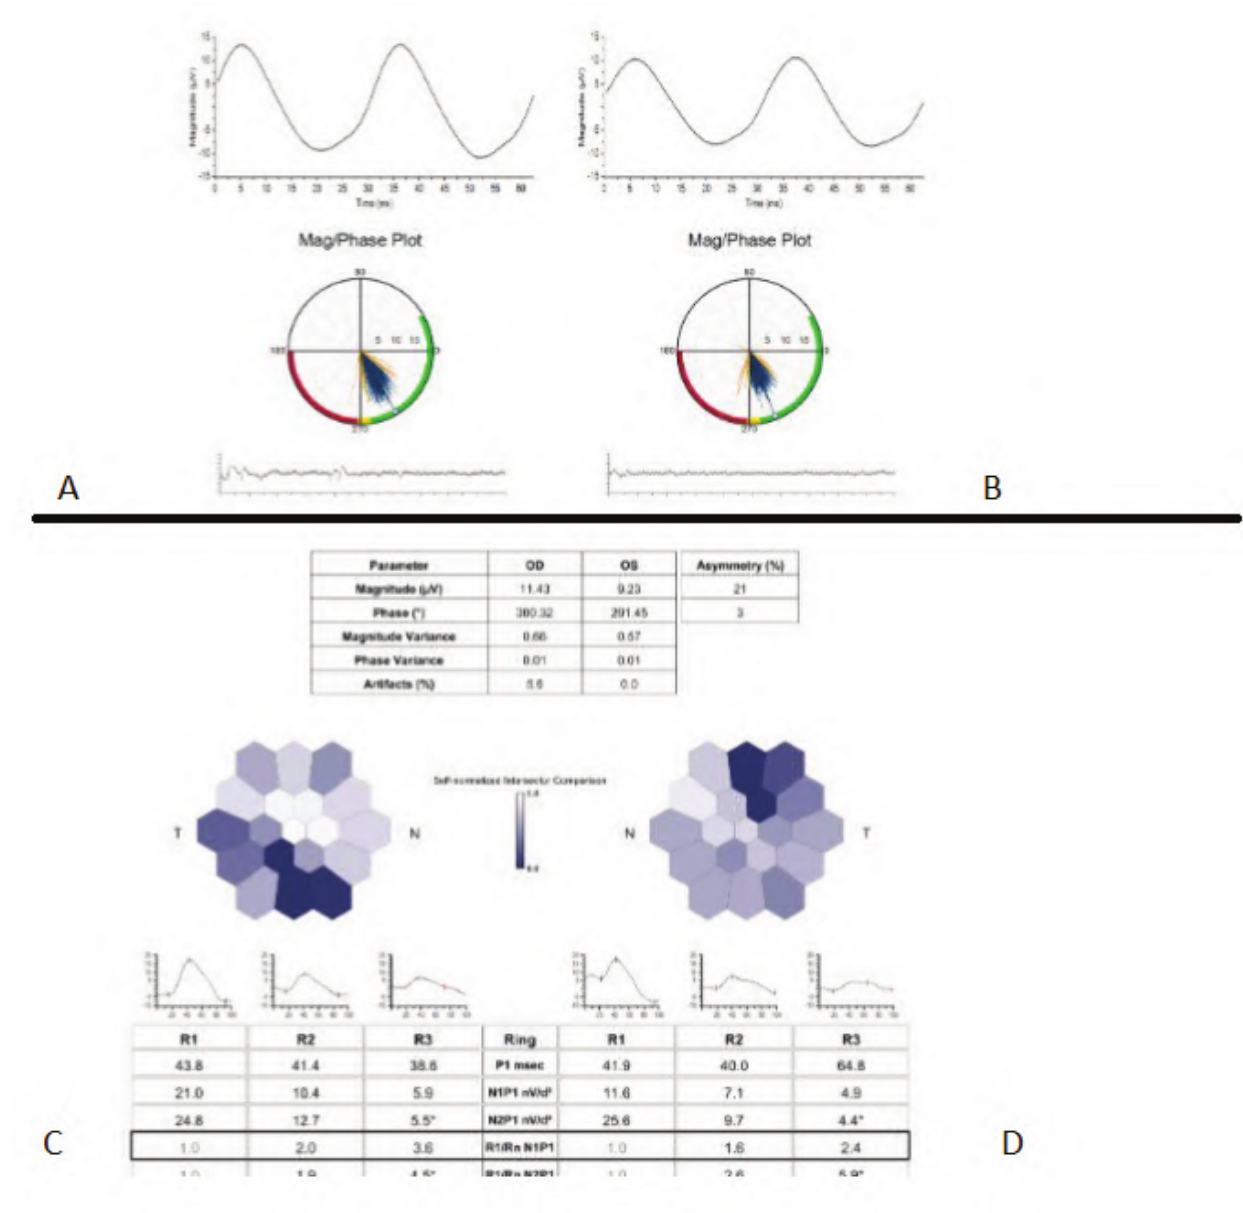
Figure 7. A and B illustrate fixed-luminance electroretinography (ERG) on Diopsys, which is equal to 30-Hz flicker conventional ERG. Waves have normal magnitude (amplitude) and phase (implicit time) in both eyes. Graphs show rays (blue lines) in the green area that means within the normal limit. C and D show multifocal ERG of the right and left eyes, respectively. C shows abnormal area inferotemporal correspondents with ellipsoid zone segmentation and disruption on macular optical coherence tomography. D shows abnormal areas in temporal and supratemporal correspondent with ellipsoid zone thinning (absent in some areas) on the macular optical coherence